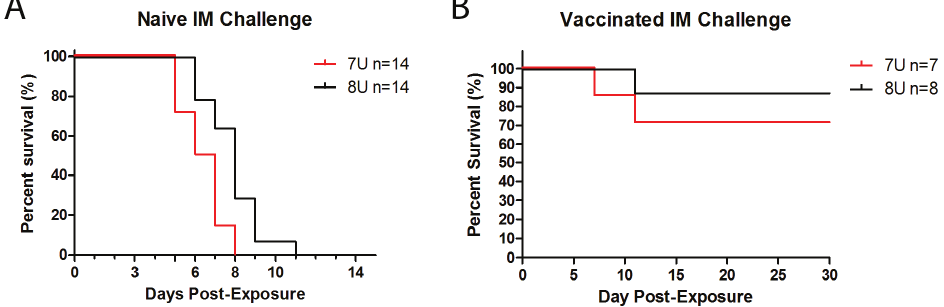
Figure 1. Survival. ( A ) Fourteen NHPs in each challenge group, 7U ( Red ) or 8U ( Black ), were exposed to a target dose of 1000 pfu EBOV on Day 0 post-exposure. The percentage of survival was documented per day post-exposure; ( B ) Groups of 8 NHPs were vaccinated with a proprietary EBOV-GP based vaccine and then exposed to a target dose of 1000 pfu EBOV on Day 0 post-exposure. The percentage of survival was documented per day post-exposure.